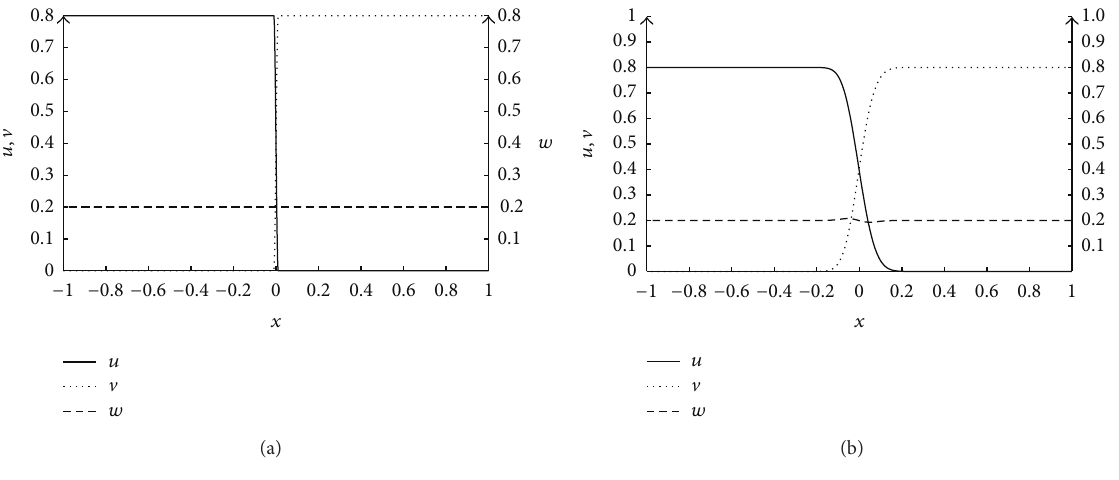
marker denoted by z (Figure 2(b)) forms a trajectory in (𝑢, V ) - plane shown in Figure 2(a). This object traces the evolution of concentrations of diffunding substances 𝑢 , V